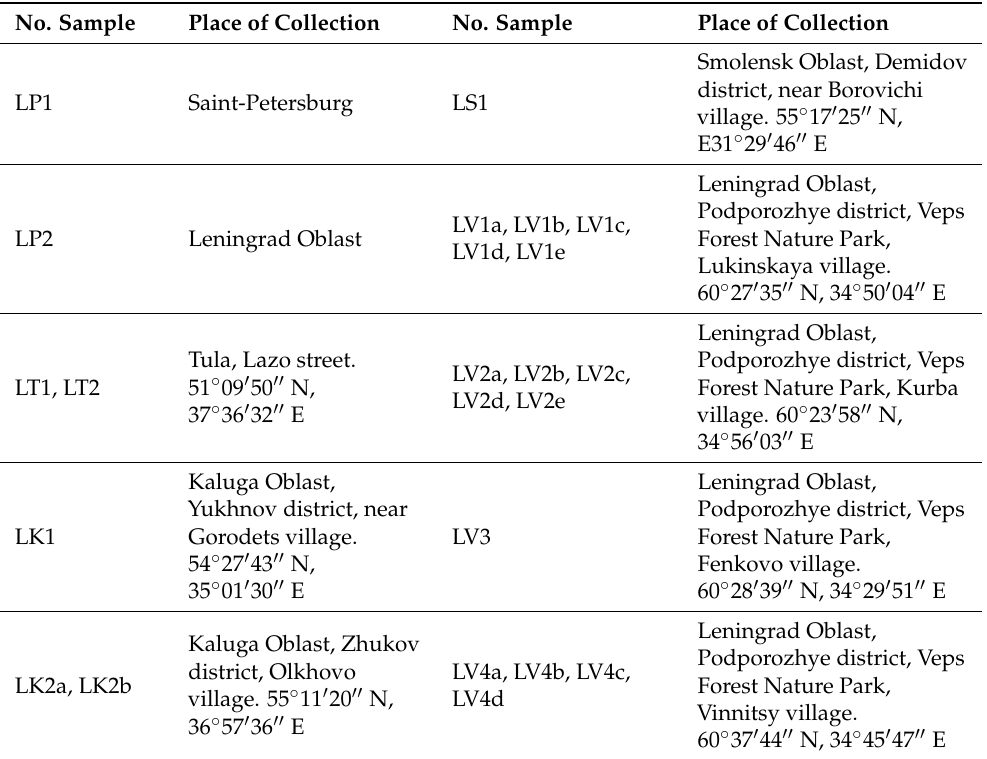
Table 1. Samples of Lupinus polyphyllus